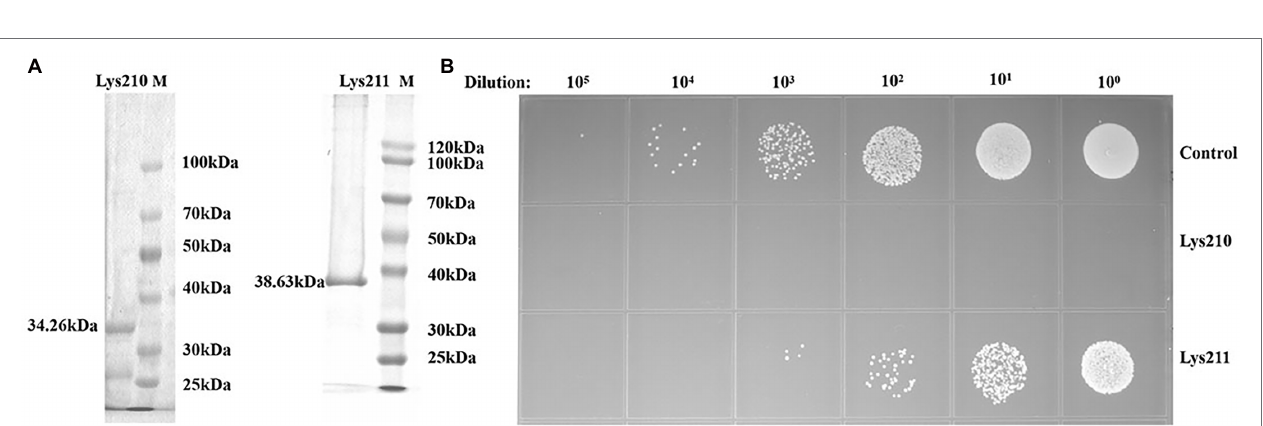
FIGURE 7 | Antibacterial activity of lys210 and lys211. (A) Purification of proteins lys210 and lys211 expressed in E. coli BL21. The concentration of SDS-PAGE gel is 15%. (B) Survival test of S. lentus JTB1-3 on LB agar dishes after the cells were lysed by lys210 and lys211 (129 μ g/ml) at 37 ° C for 1